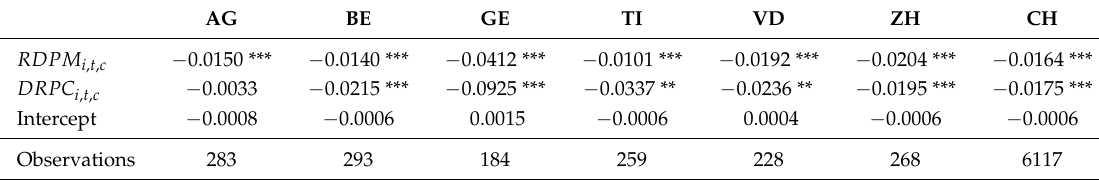
Table 4. Multivariate regression results with two-sided lognormal residuals.